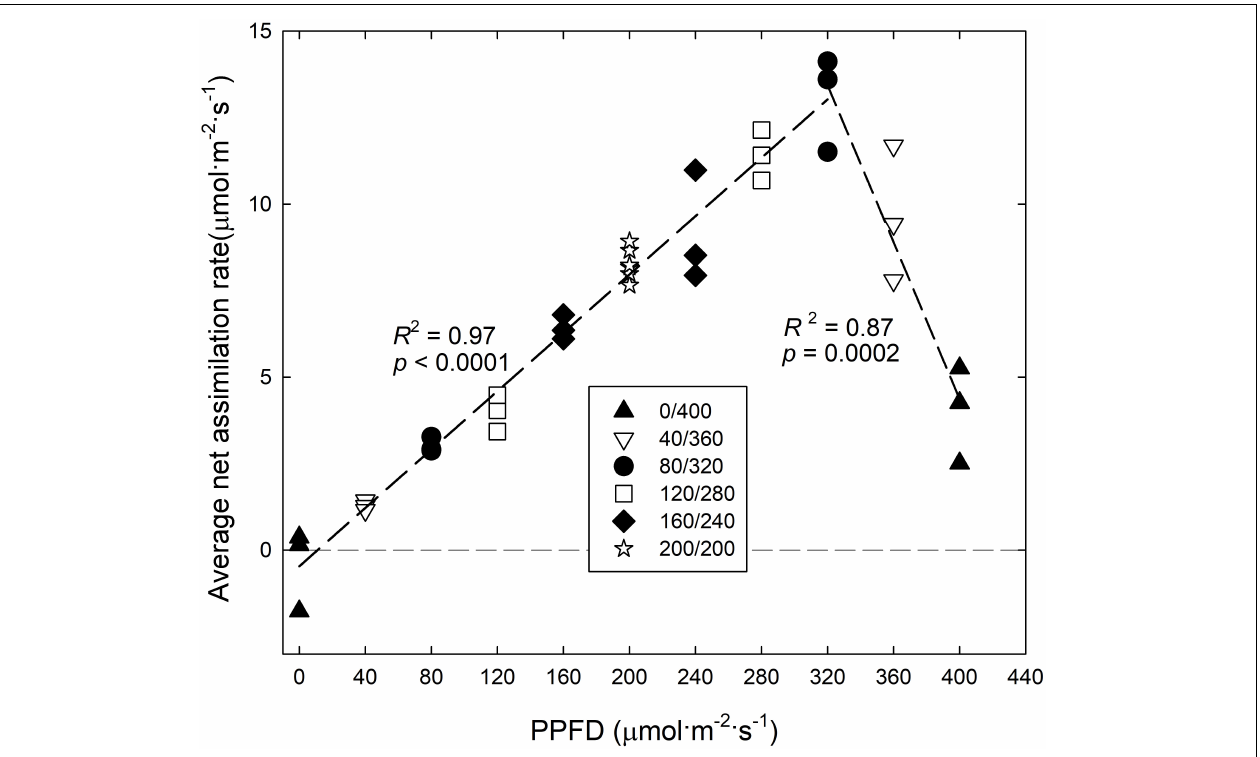
FIGURE 5 | Average net assimilation rate over 15 min (A n , 15 ) of ‘Green Salad Bowl’ lettuce ( Lactuca sativa ) as a function of photosynthetic photon flux density (PPFD). Photosynthesis was measured for 15 min under high PPFD, followed by 15 min under low PPFD (see Figure 2 ). Plants were grown under fluctuating PPFD, changing every 15 min between high and low PPFD ( ∼ 400/0, 360/40, 320/80, 280/120, 240/160, and 200/200 µ mol · m − 2 · s − 1 ).